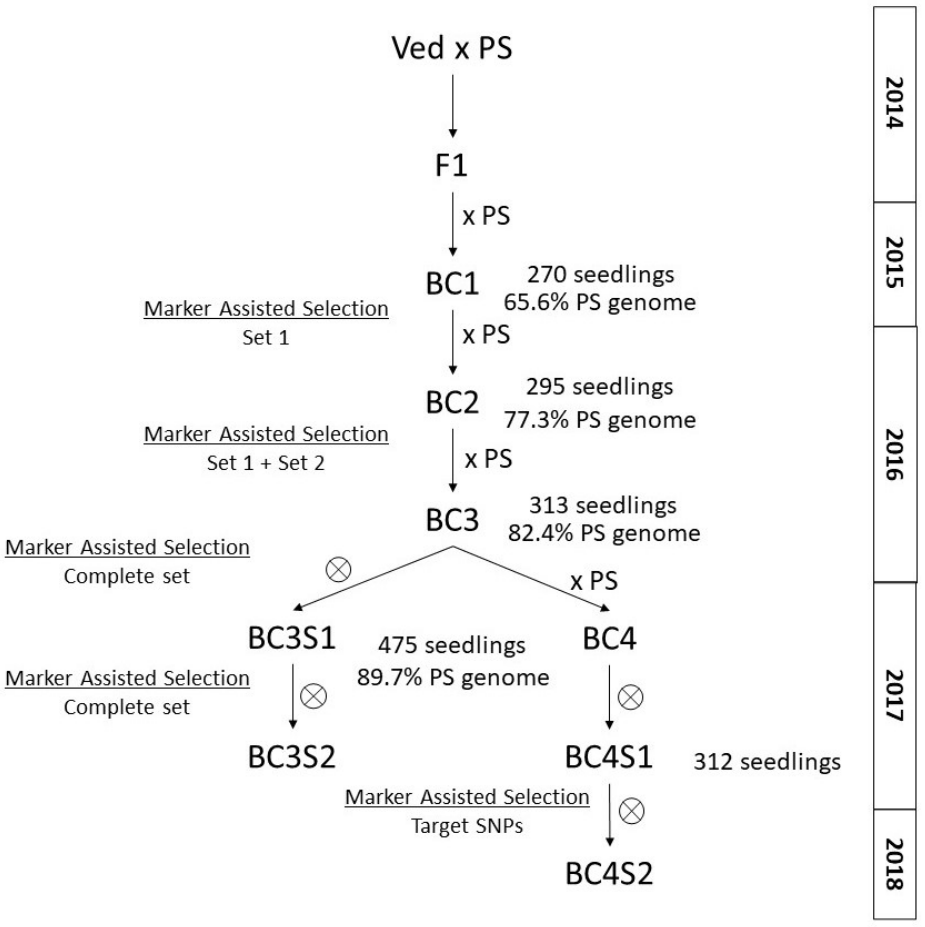
Figure 2. Simplified breeding scheme for the development of the IL population, showing the number of seedlings analyzed and the average PS genome at each generation.